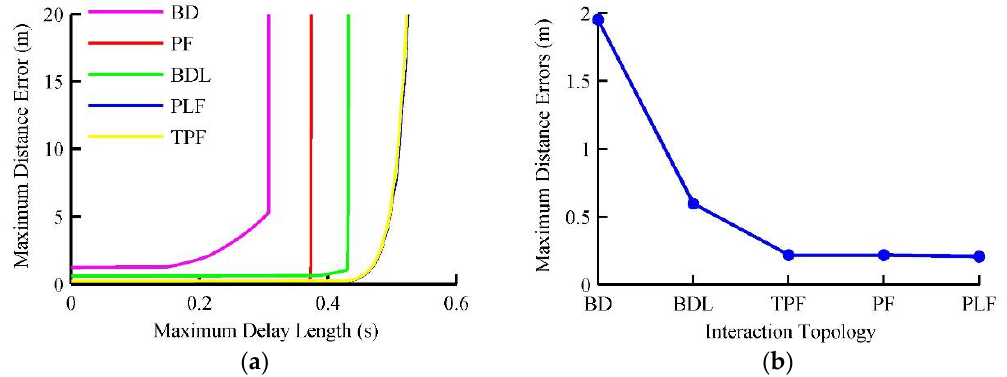
Figure 6. The upper limit of communication delay under different topologies. ( a ) Maximum delay of different topologies. ( b ) Maximum distance errors under different topologies.